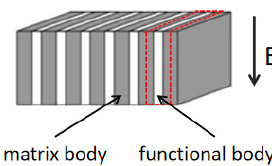
Figure 4. Representative volume unit.